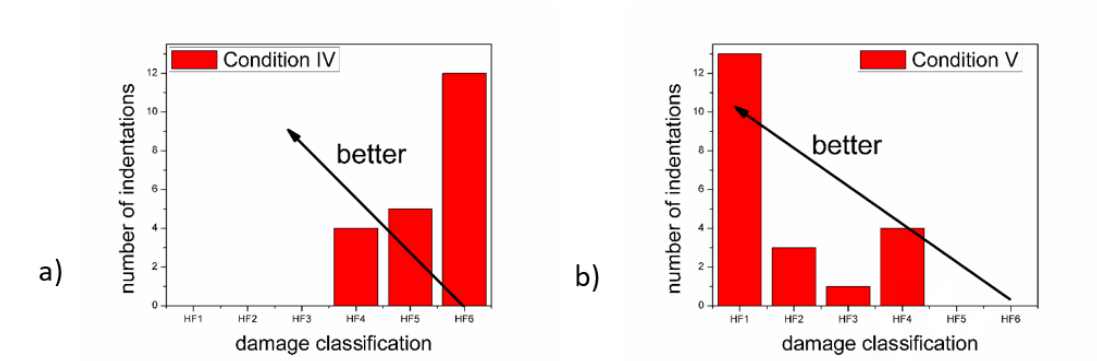
Figure 12. RC Indentation Graphics: a) Condition IV, b) Condition V.